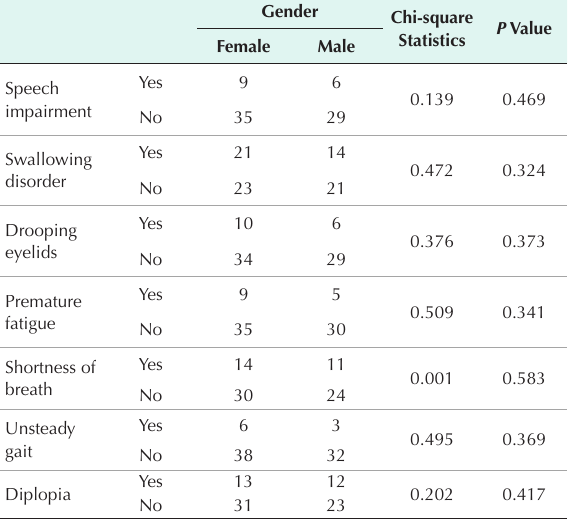
Table 5. Frequency Distribution of Disease Symptoms and Gender of Patients and the Relationship Between Disease Symptoms and Patients’ Gender Gender